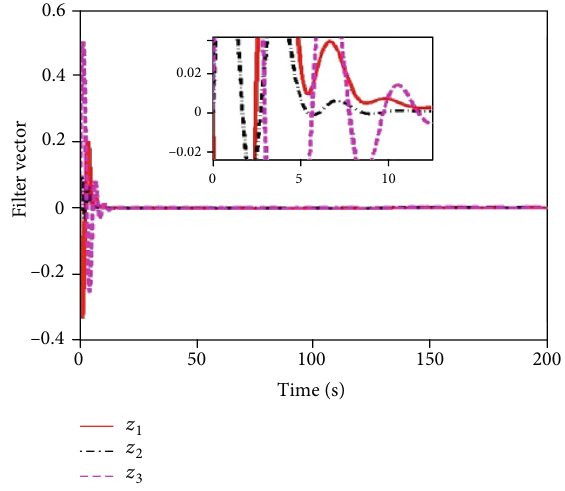
Figure 25: Time histories of fi lter vector in Case 3 when k ð 0 Þ = 10